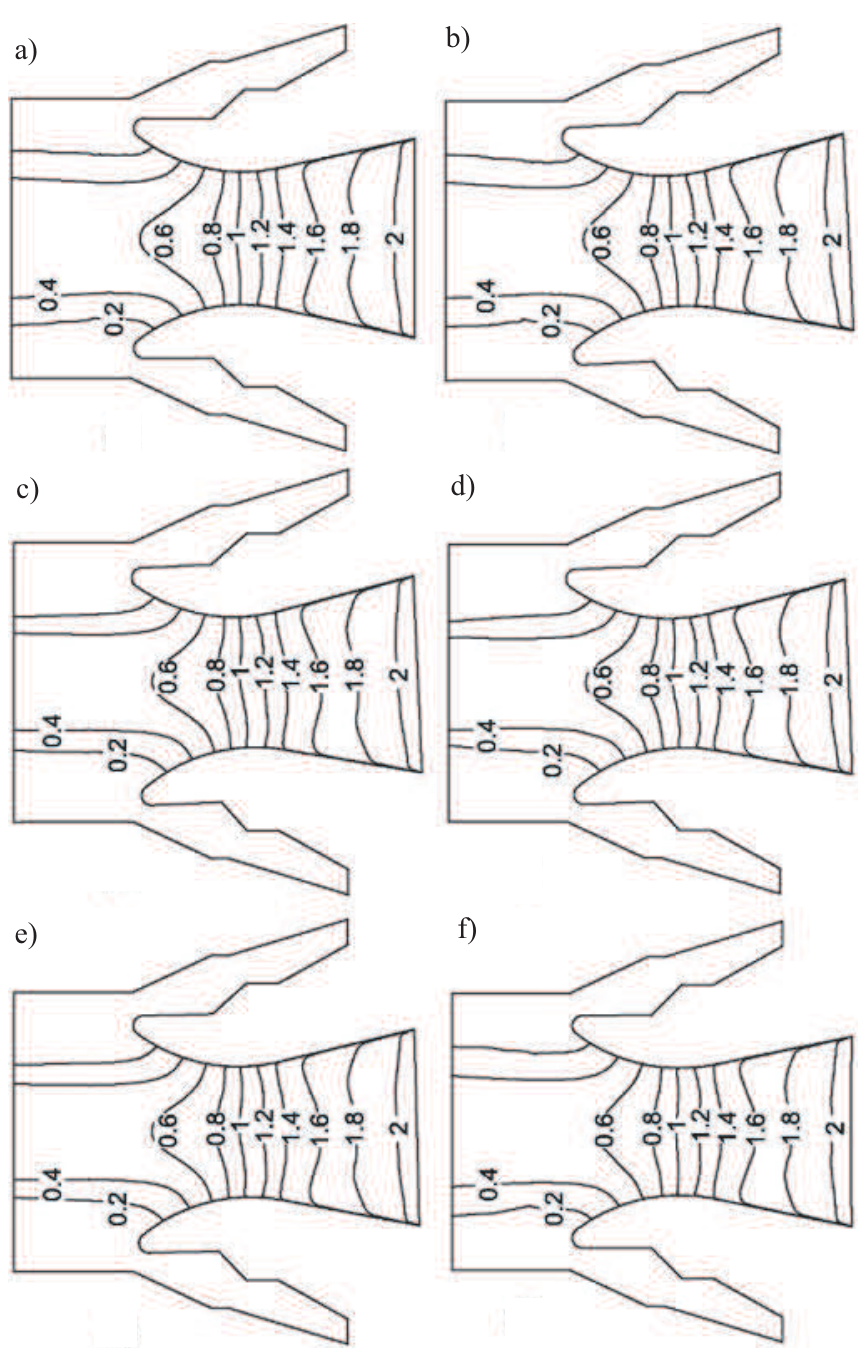
Figure 14. Contours of Mach number in nozzle for various planes for angle of nozzle rotation 3 ◦ ( a – f